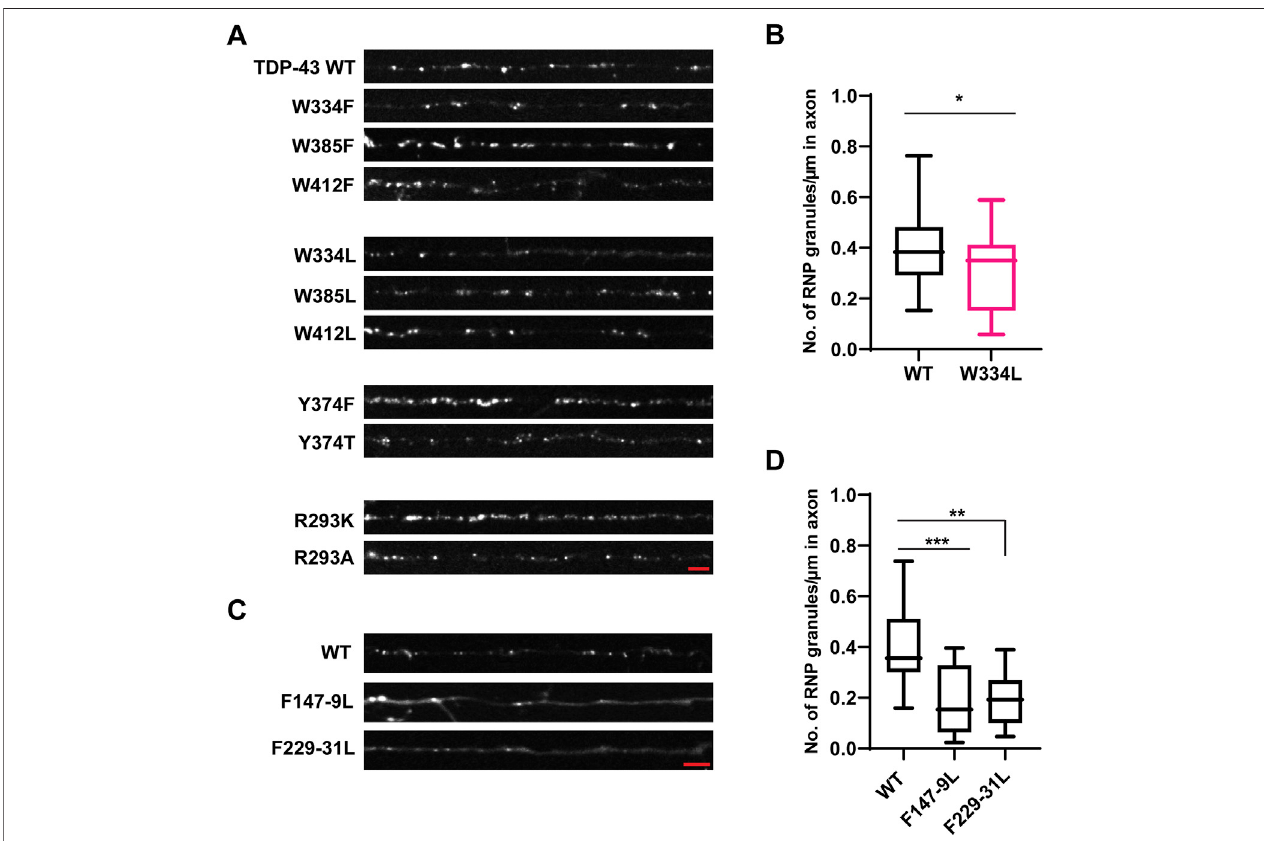
FIGURE4| Aromaticmutant W334L affects RNPgranuleassembly. (A) TDP-43RNPgranules areobservedalongtheaxonsofDIV7 – 10primary corticalneurons expressingtheGFPtaggedWTTDP-43,aromaticorRGGTDP-43mutants.RepresentativeimagesofWToraromatic/RGGmutantRNPgranulesareshown.Scalebar (shown in red) corresponds to 3 μ m. (B) Number of RNP granules per μ m length of axon for WT TDP-43 and W334L TDP-43 mutants is plotted (see Materials and Methods ) from n = 13 – 15 neurons per condition, from 3 independent experiments ( N = 3). Error bars represent standard error mean. Unpaired t- test was used to determine statistically signi fi cantdifferencebetween WT and W334L TDP-43RNPgranules,* p < 0.05. (C) Representative images ofGFPtagged WT TDP-43and RRM mutant RNP granules are shown. Scale bar (shown in red) corresponds to 3 μ m. (D) Number of RNP granules per μ m length of axon for WT TDP-43 and TDP-43 RRM mutantsisshownfrom n =11 – 12neuronspercondition,from3independentexperiments( N =3).OnewayANOVAwithDunn ’ scorrectionformultiplecomparisonswas used to test for statistically signi fi cant differences among samples; ** p < 0.01, *** p < 0.001.